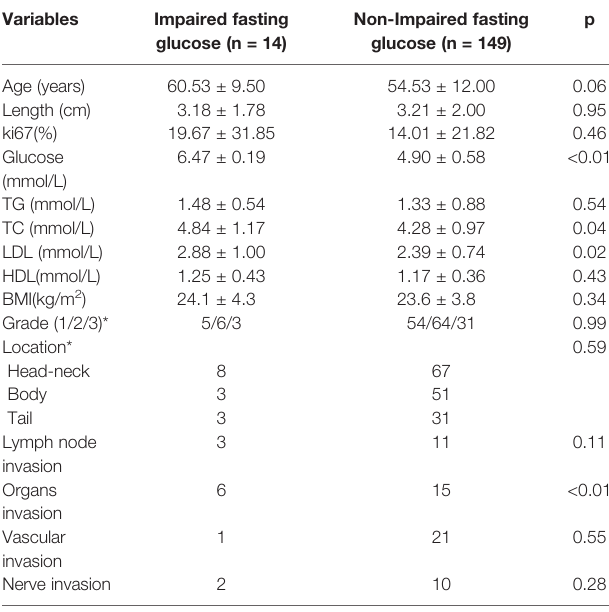
TABLE 2 | Characteristic of patients based on impaired fasting